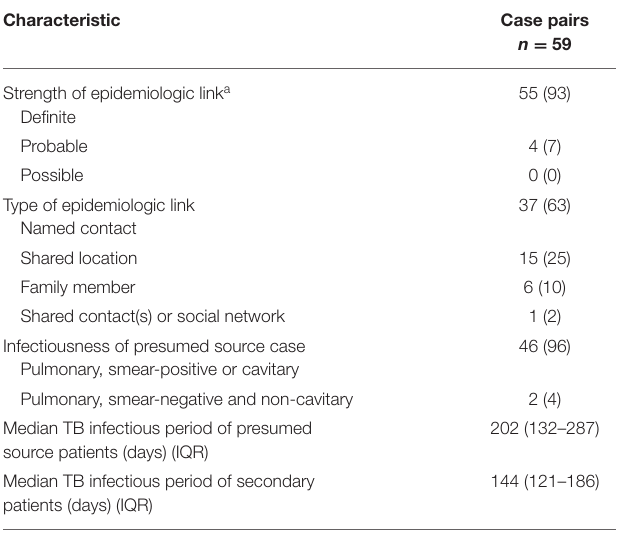
TABLE 2 | Epidemiologic and infectiousness characteristics of genotype-matched TB source–secondary case pairs in Los Angeles County, California, 2015–2018, included in the analytic data